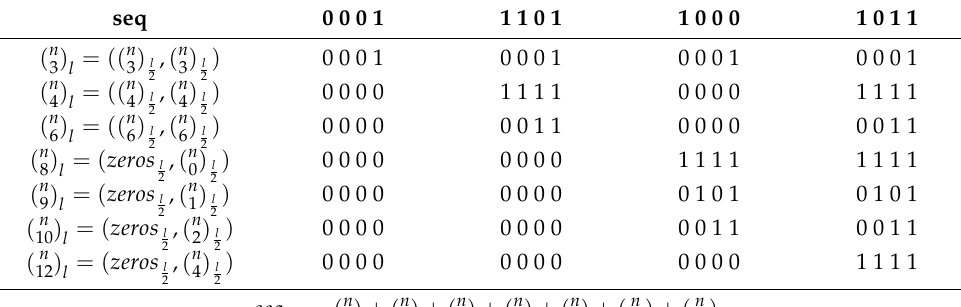
Table 4. Theorem 1 applied to the binomial decomposition of seq 16